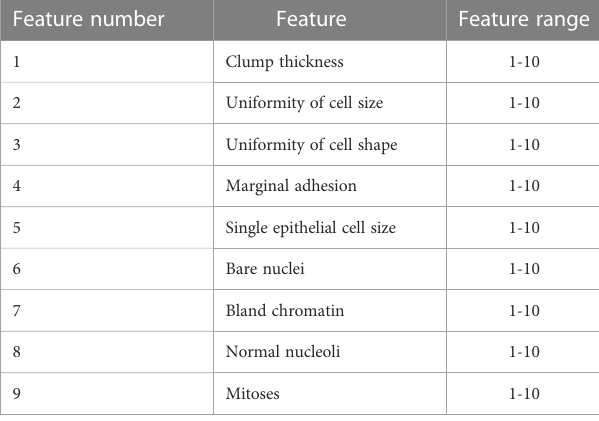
TABLE 3 Illustration of the WBCD features